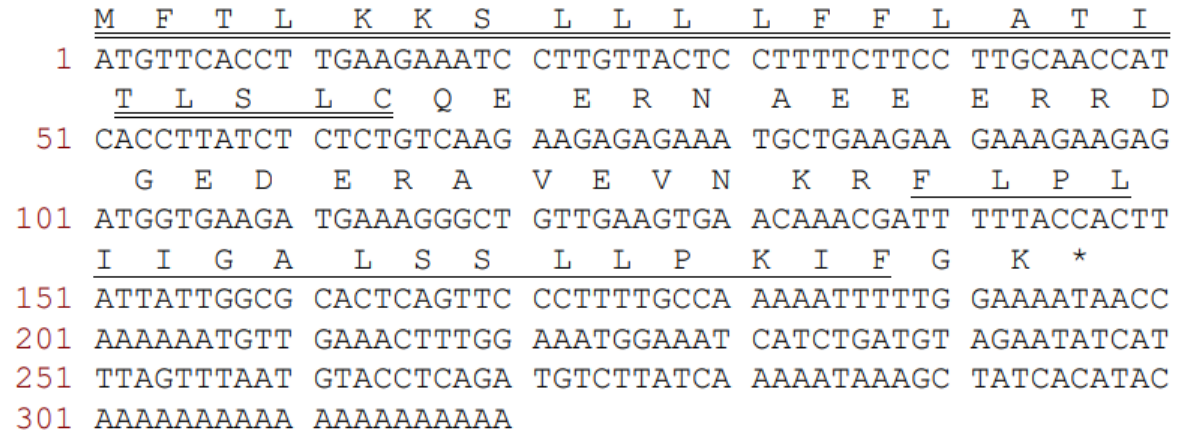
Figure 1. The nucleotide and the translated open-reading frame amino acid sequence of the precursor-encoding cDNA of a novel peptide, temporin-PKE, was cloned from Pelophylax kl. esculentus skin secretion. The putative signal and mature peptides are underlined by a bold line and a single line, respectively. An asterisk indicates the stop codon. The full nucleotide sequence is numbering on the left-hand side.